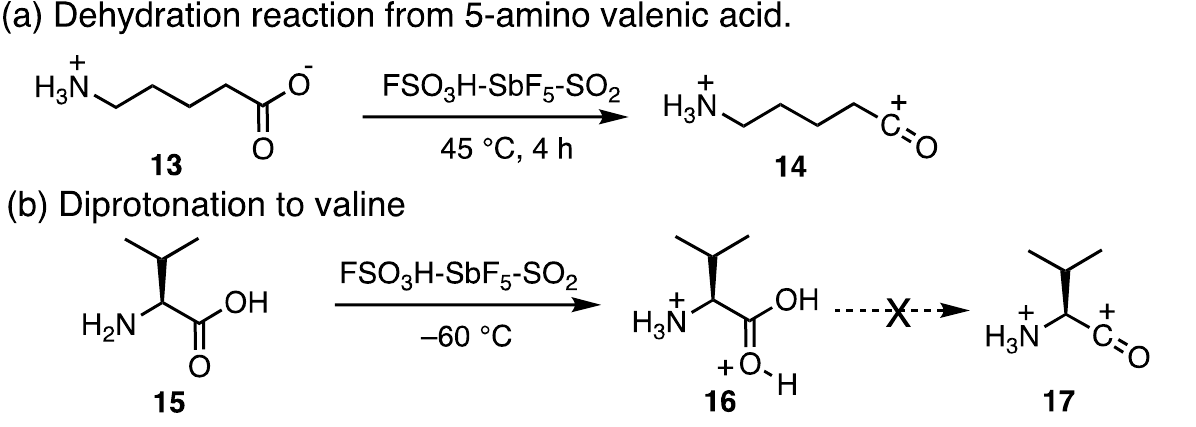
Scheme 6. Acylium ion formation from amino acids. Distance dependency: ( a ) ionization of the carboxylic acid 13 to acylium ion 14 ; ( b ) ionization of the carboxylic acid 15 to acylium ion 17 is prohibited. Only 16 is